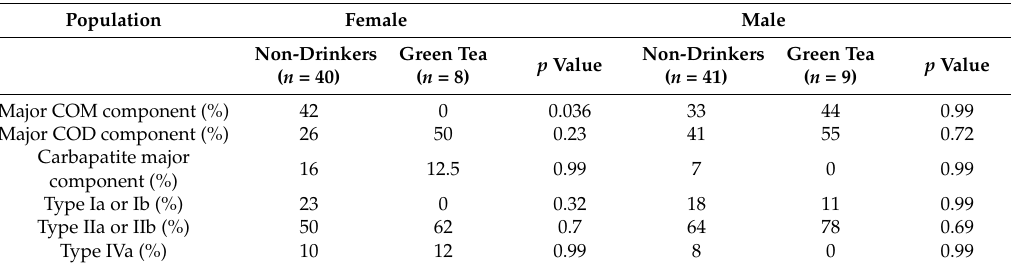
Table 4. IRS analysis of stones collected from drinkers and